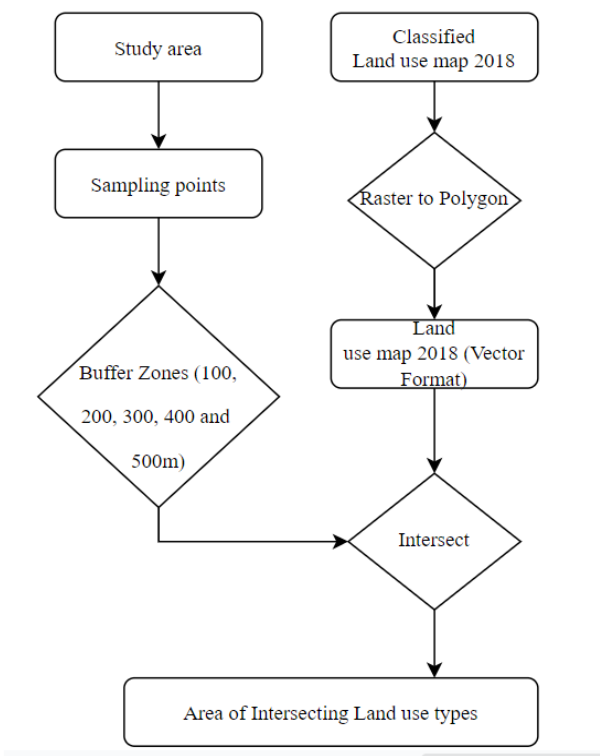
Figure 2: The steps involved in intersecting land use area calculation.